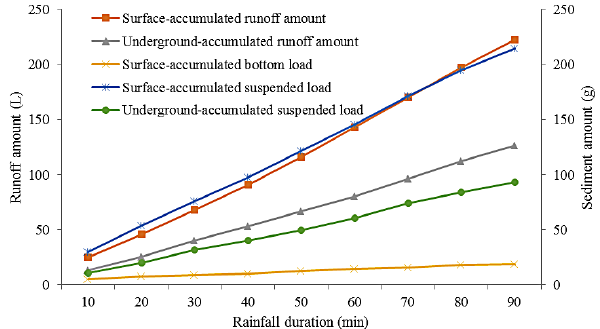
Figure 3. Change of accumulation runoff and sediment with in- creasing rainfall time (experiment conditions: rainfall intensity is 50 mmh − 1 ; degree of pore fissure is 30%; bedrock rate is 3%; slope steepness is 25 ◦ ).